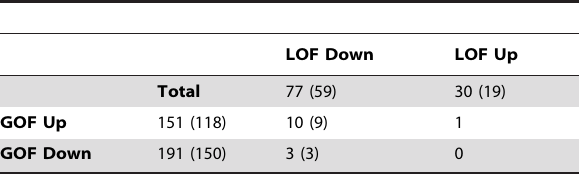
Table 1. Expression changes in Hoxa2 loss of function (LOF) and Hoxa2 gain of function